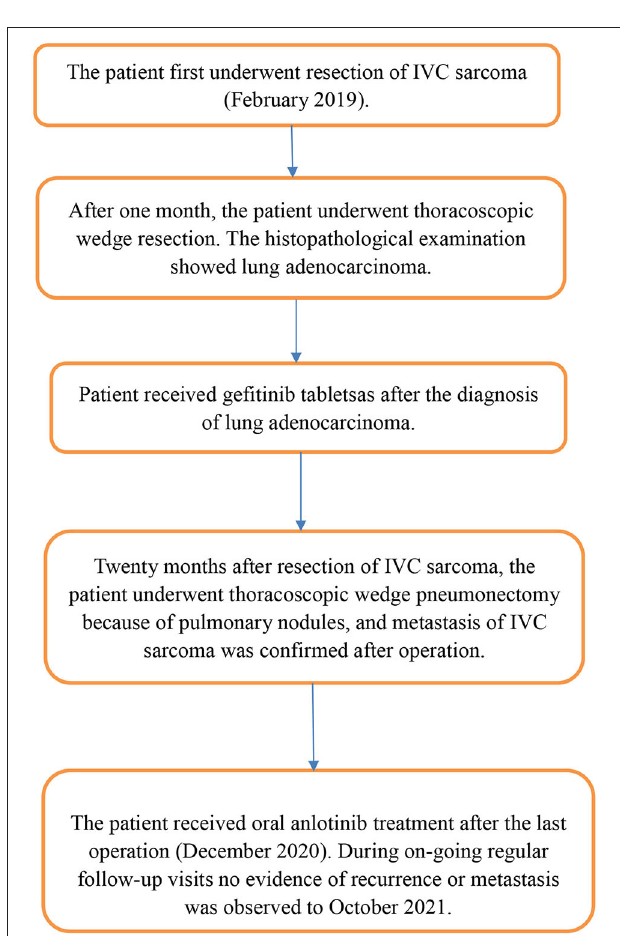
FIGURE 9 | Historical and current information from this case organized as a